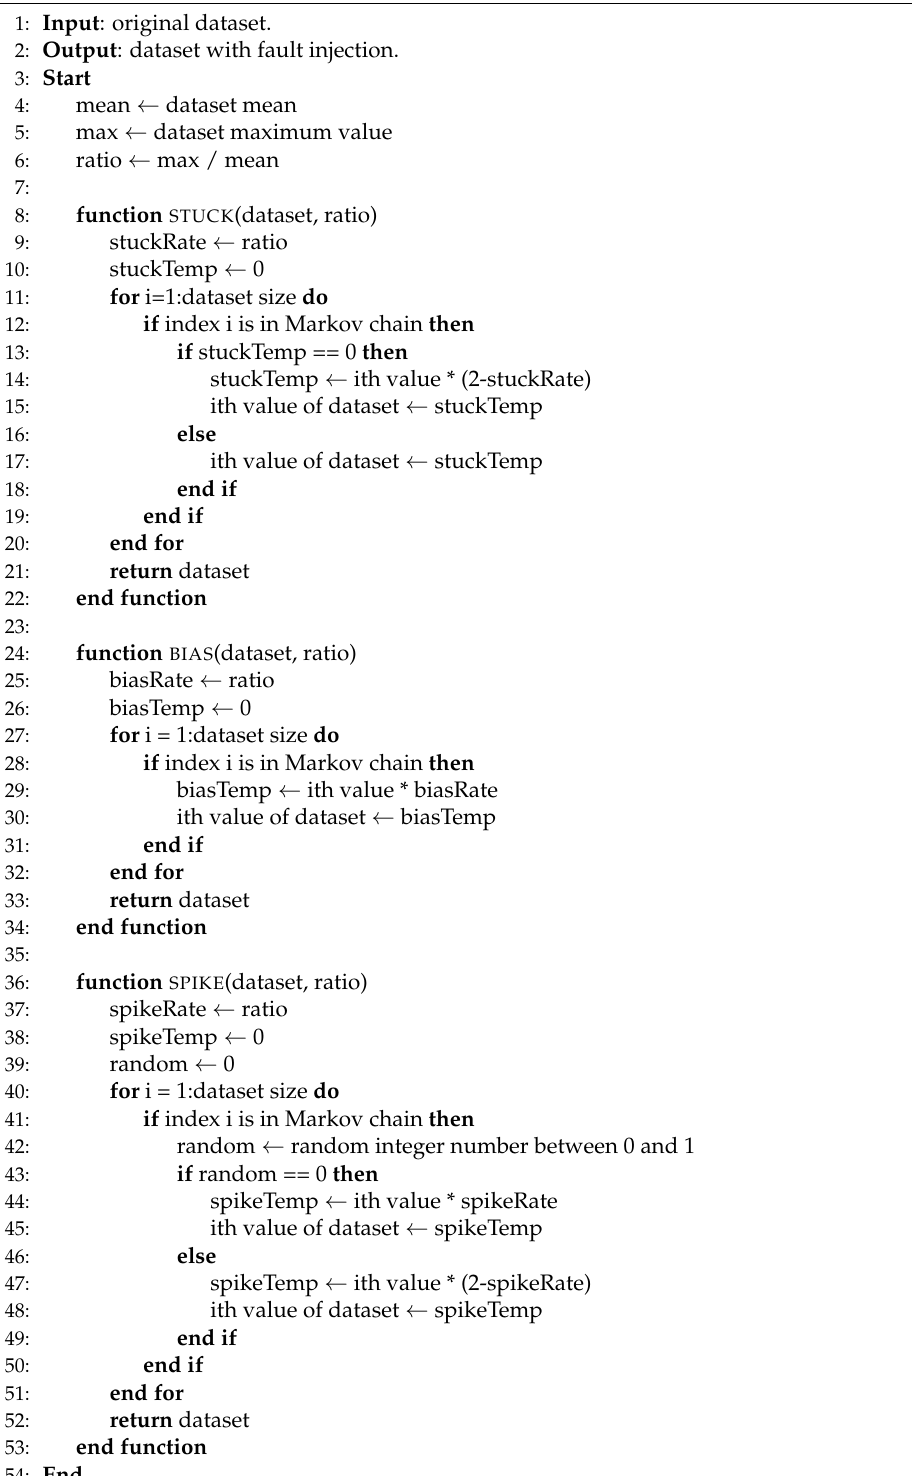
Algorithm 1 Fault Injection